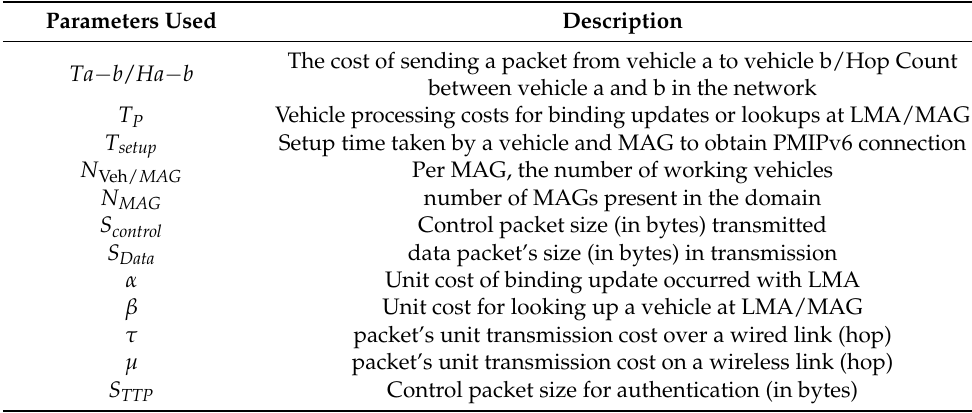
Table 1. Parameter description used for cost analysis of VANET in PMIPV6.